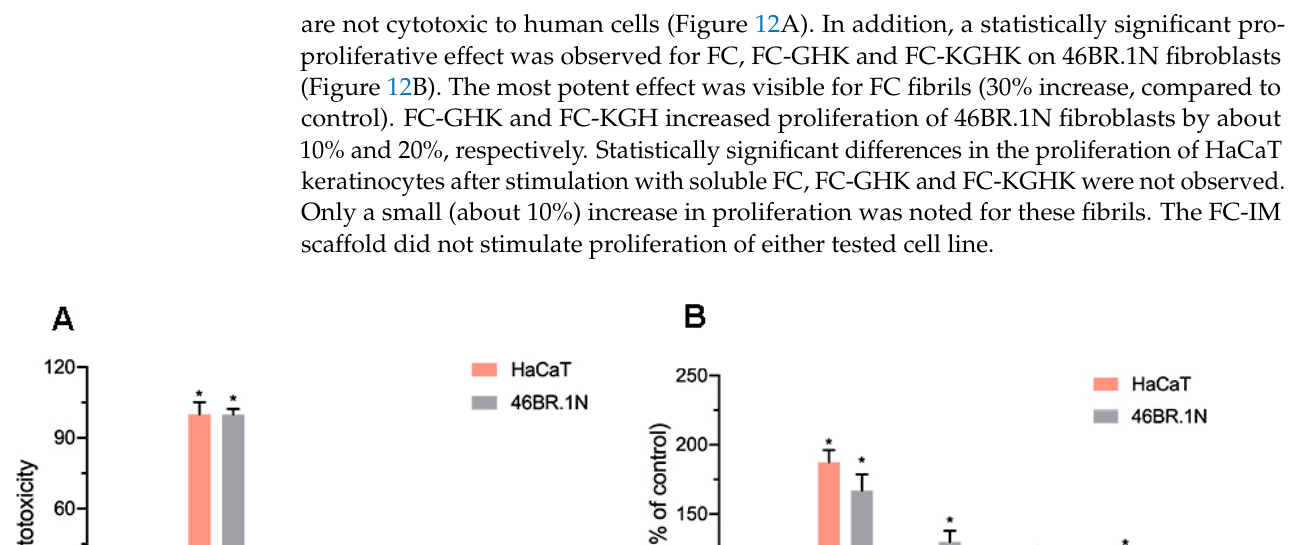
Figure 11. Effect of tested peptides on collagen synthesis in 46BR.1N fibroblasts. The graph shows results from three independent experiments. Results are presented as mean with SEM. *- statisti- cally significant differences compared to control, Mann-Whitney U test, p < 0.05.